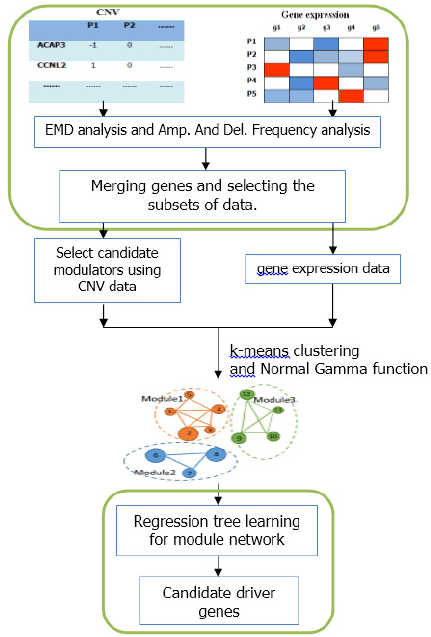
Figure 5. Schematic diagram of the integrative method based on module-network. The first part indicates the pre-processing steps based on the differential expression analysis. The middle part is the construction of the initial modules. The bottom part represents the process of module network learning.